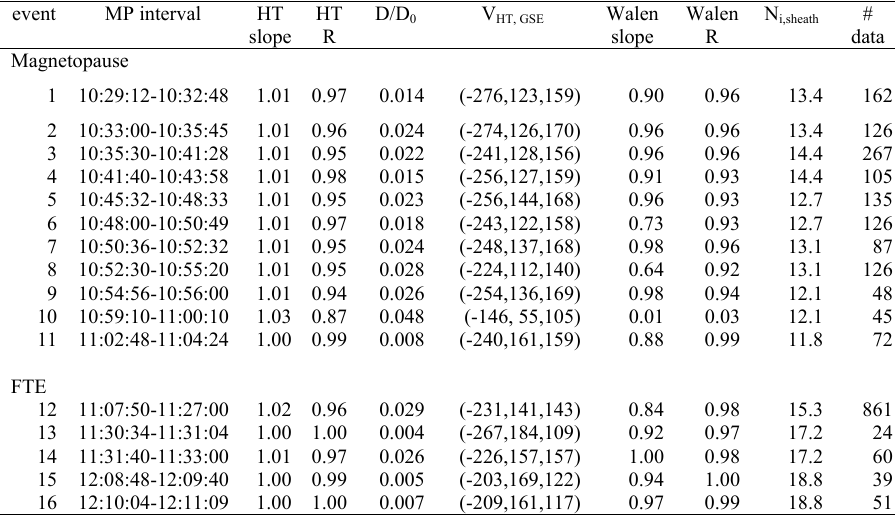
Table 1. Summary or HT and Wal´en analyses on complete MP current layer crossings and FTEs. Table 1. Summary or HT and Walén analyses on complete MP current layer crossings and FTEs